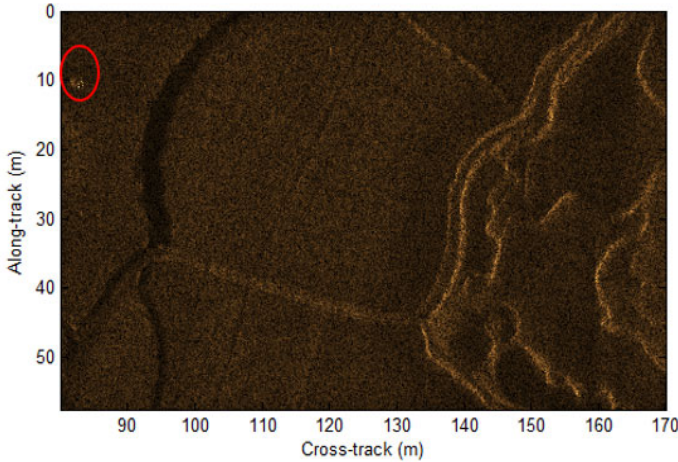
Figure 13. Real-data processing result with traditional BP algorithm. The area circled by red circle is a reconstructed target, which would be discussed in the following part.